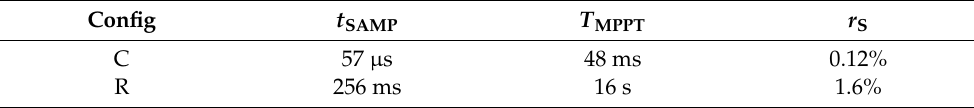
Table 2. Sampling parameters for each configuration.